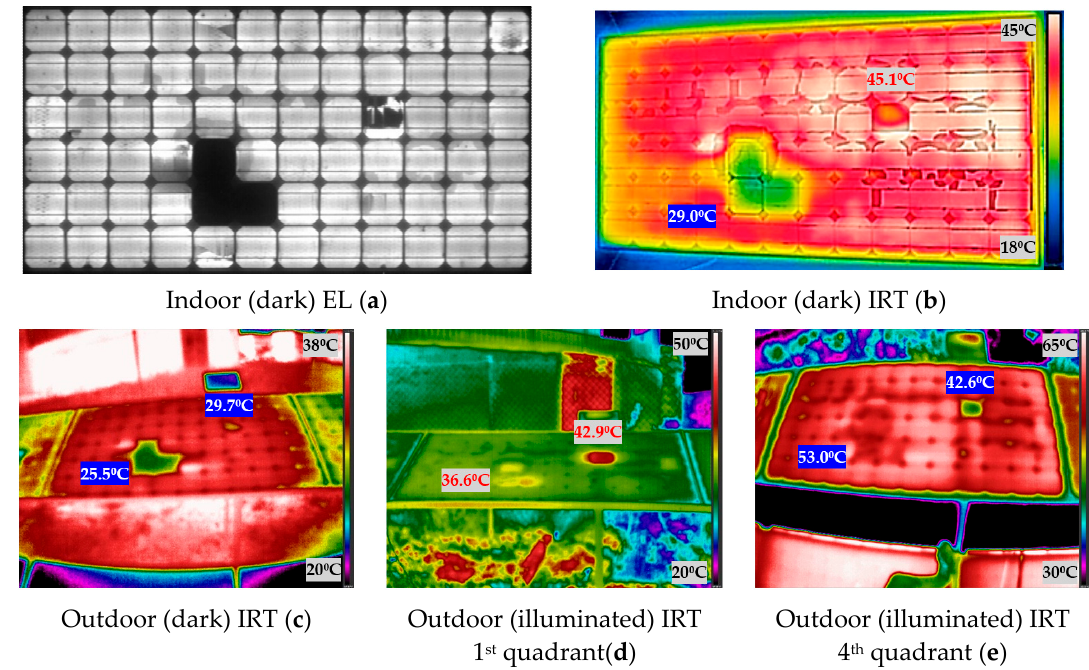
Figure 10. Indoor and outdoor characterization images of module 2: ( a ) indoor (dark) EL; ( b ) indoor (dark) IRT; ( c ) outdoor (dark) IRT; ( d ) outdoor (illuminated) IRT first quadrant; ( e ) outdoor (illuminated) IRT fourth quadrant.